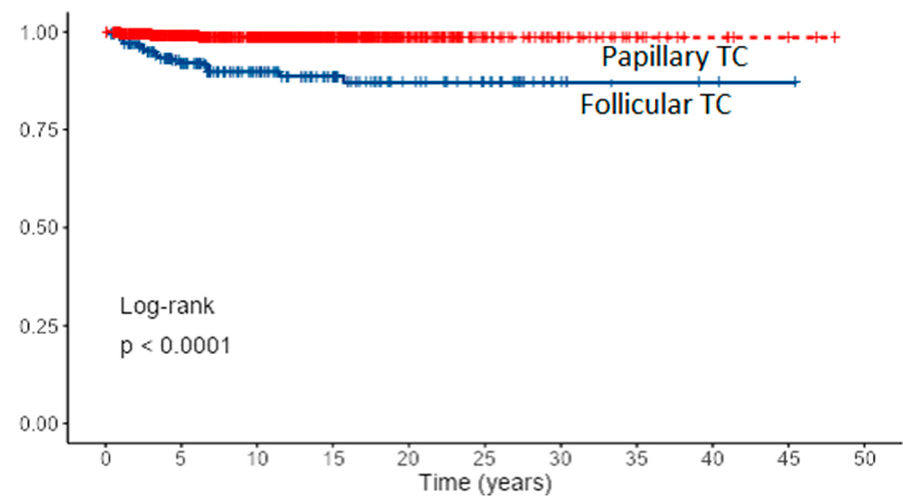
Figure 4. Survival curves for PTC and FTC patients based on Kaplan–Meier estimates.